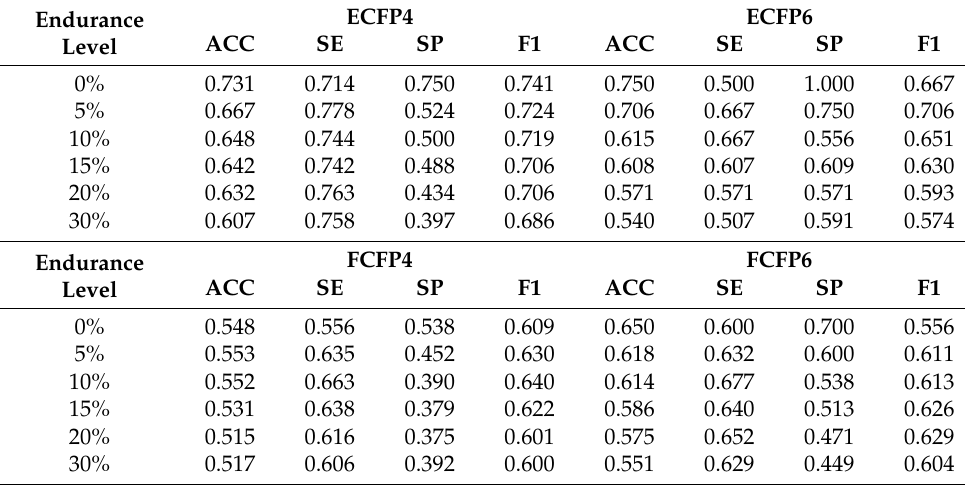
Table 3. Comparison of the deep neural network models by molecular